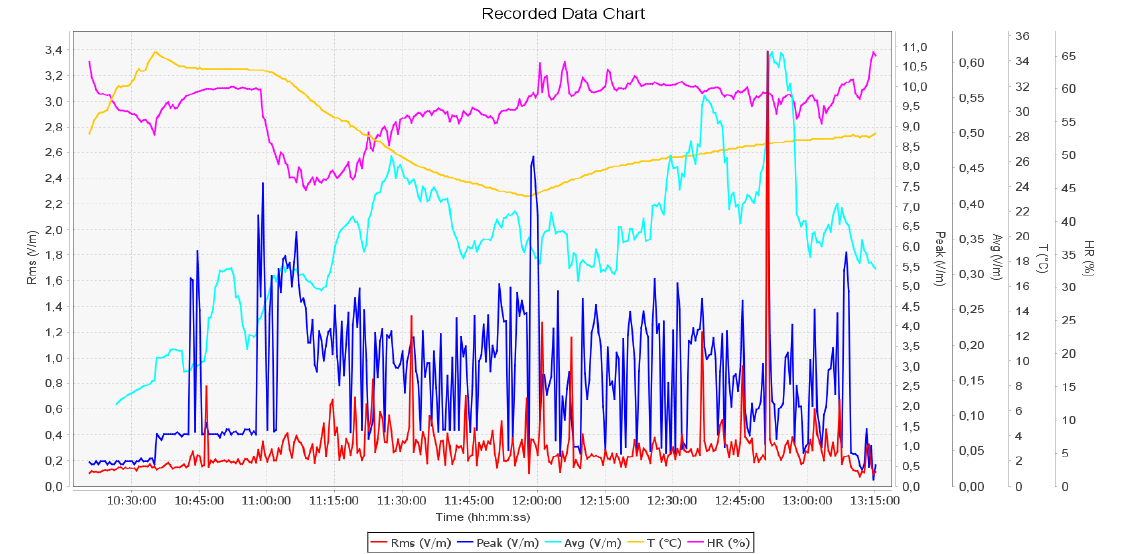
Figure 10. The intensity of the electrical component of the electromagnetic field in the course of flight no. 2 for the Tecnam P2006T.